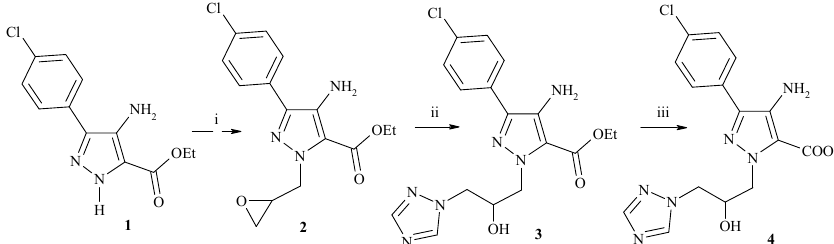
Scheme 1. Synthesis of triazolo pyrazole derivatives. Reagents and conditions: (i) 2-(chloromethyl)oxirane,